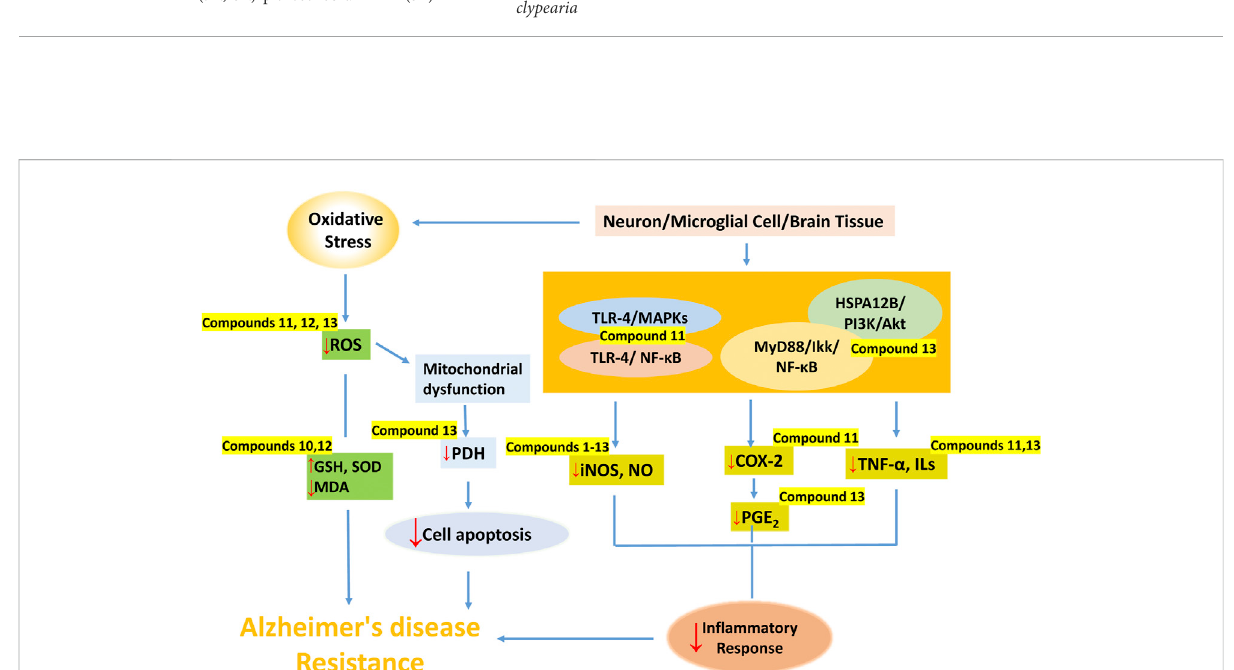
FIGURE 3 The main mechanisms of dibenzocyclooctene lignans against AD. (Dibenzocyclooctene lignans play a protective role in the nervous system through anti-in fl ammation, antioxidation and inhibition of neuronal apoptosis. Compounds 1 – 13 inhibited theactivity of NO, compounds 11 and 13 inhibited the release of downstream in fl ammatory factors by regulating TLR-4-mediated NF- κ B and MAPKs signaling pathways, MyD88/IKK/NF- κ B andHSPA12B/PI3K/Aktsignalingpathways.Inaddition,Compounds 10 and 12 up-regulatedtheexpressionofSODandGSH,andinhibitedMDA inbraintissue,while compounds 11 and 13 reducedthecontent ofROSto resistoxidativestress.Compound 13 alsoinhibitedapoptosis byinhibiting JNK-mediated PDH